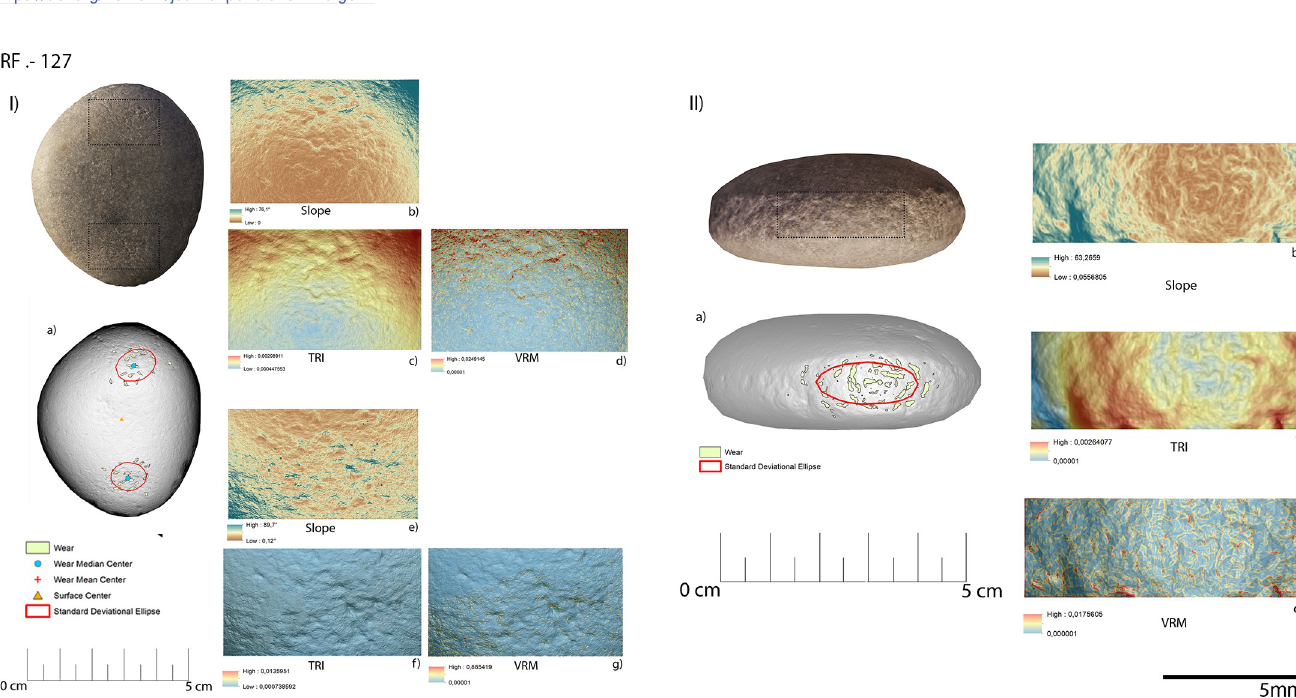
Fig 28. Archaeological items RF127. The surface of the tool (I) has been used in retouch activities while its edge (II) was used to produce bladelets/core adjustment. (a) Spatial distribution of the identified wear; (b) slope; (c) terrain roughness index; (d) vector roughness measure.